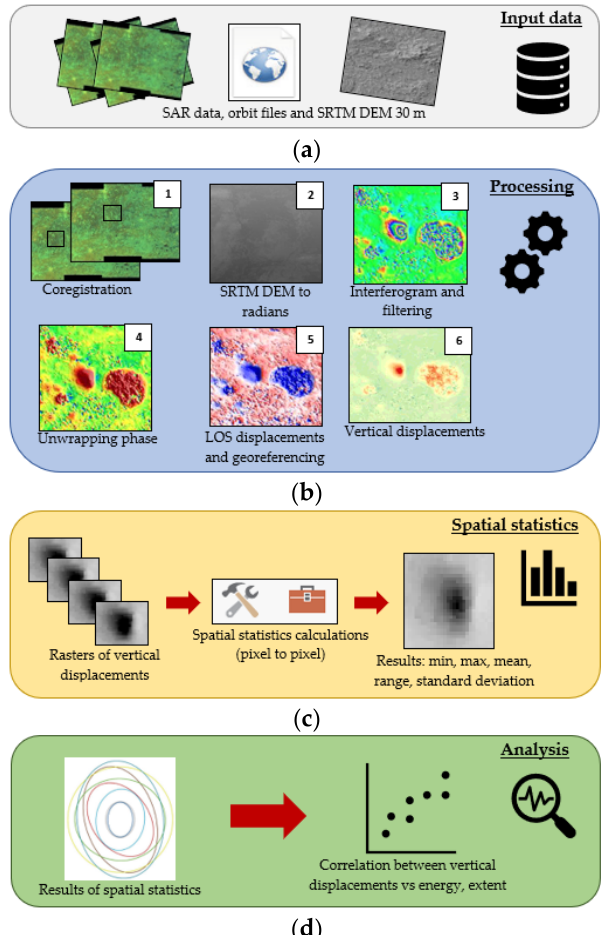
Figure 3. Workflow of research consisting of four main stages: ( a ) collecting and preparing input data, ( b ) performing calculations using the DInSAR method, ( c ) descriptive and spatial statistics calculations, ( d ) analyzing the results in the context of deformation geometry